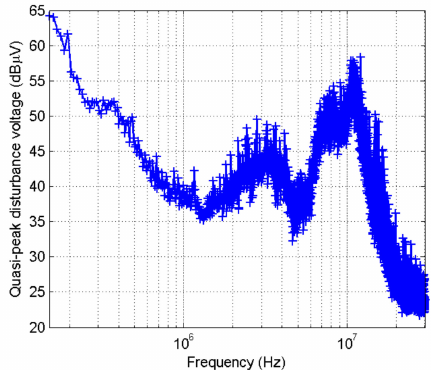
Figure 8. Testing for the conducted EMI. Measurement results for the motor loaded with the full rated torque, with PWM modulation, at the speed of n = 5000 rpm, with an input EMC filter. The drive was fed with the full AC line voltage of 230 V RMS , 50 Hz. The introduction of a PWM control increases the noise levels to around a 100-kHz frequency, but the rest is comparable to the nonmodulated control case.